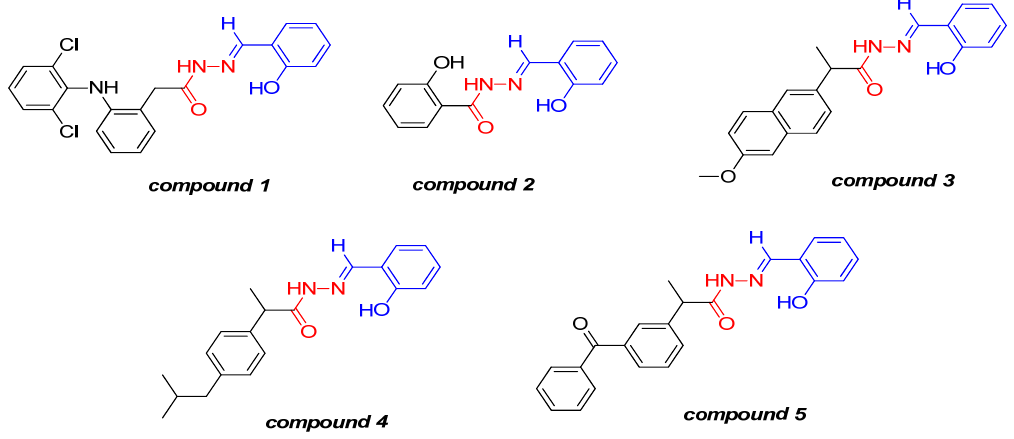
Figure 2. Structures of compounds 1 – 5 , which were obtained by molecular hybridization of a NSAID, ASA, and an NAH